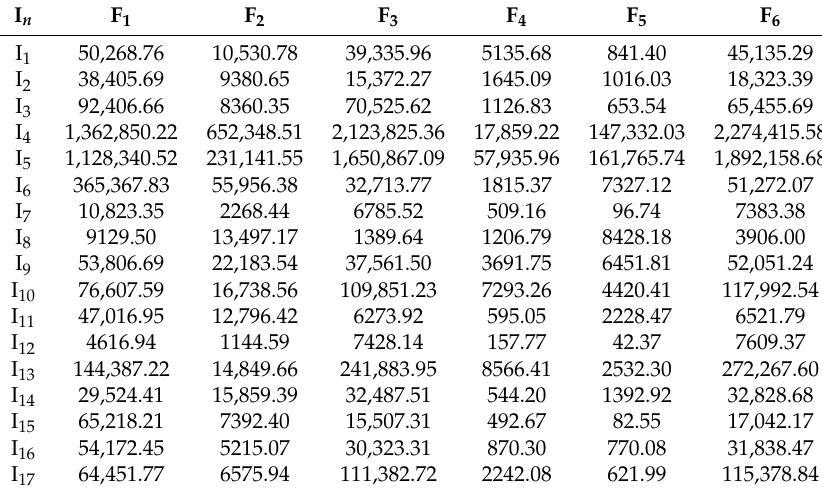
Table 10. Forecast data in 2019.